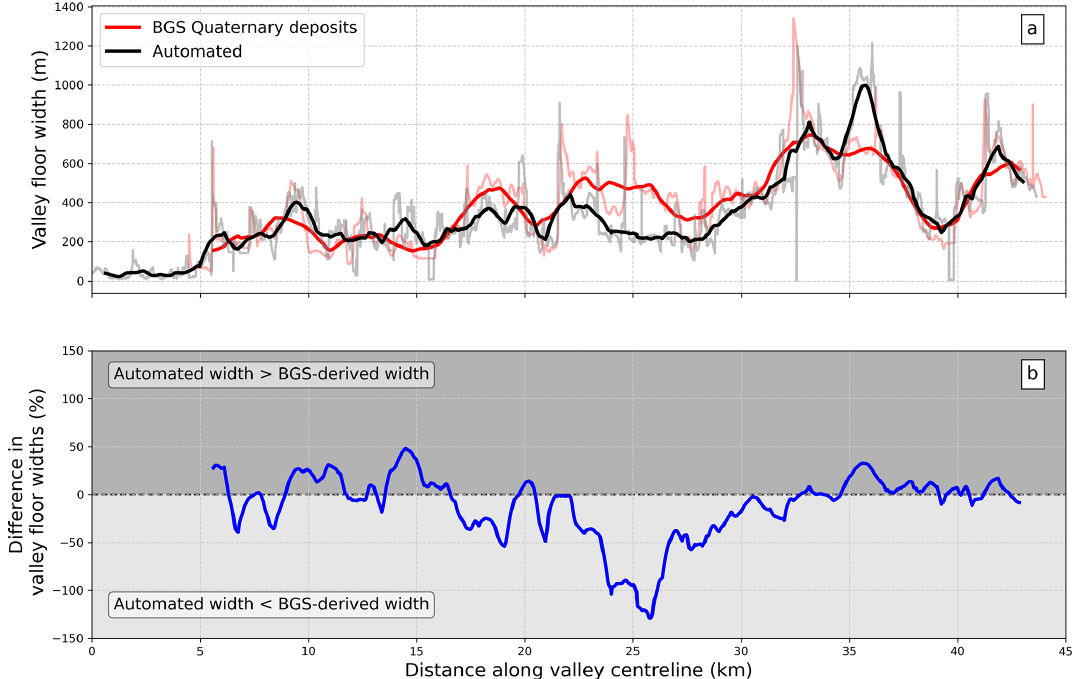
Figure 7. Results of valley floor width comparison for Weardale. (a) valley floor width from upstream to downstream along the centreline for the automated method (black) and derived from the BGS Quaternary maps (red). The light grey and red lines show the raw data, and the darker lines show a rolling average of width over a 500m window. (b) Percentage difference between the two datasets along the centreline, where positive values indicate a wider automated width than BGS derived, and negative values indicated a narrower automated width than BGS derived.